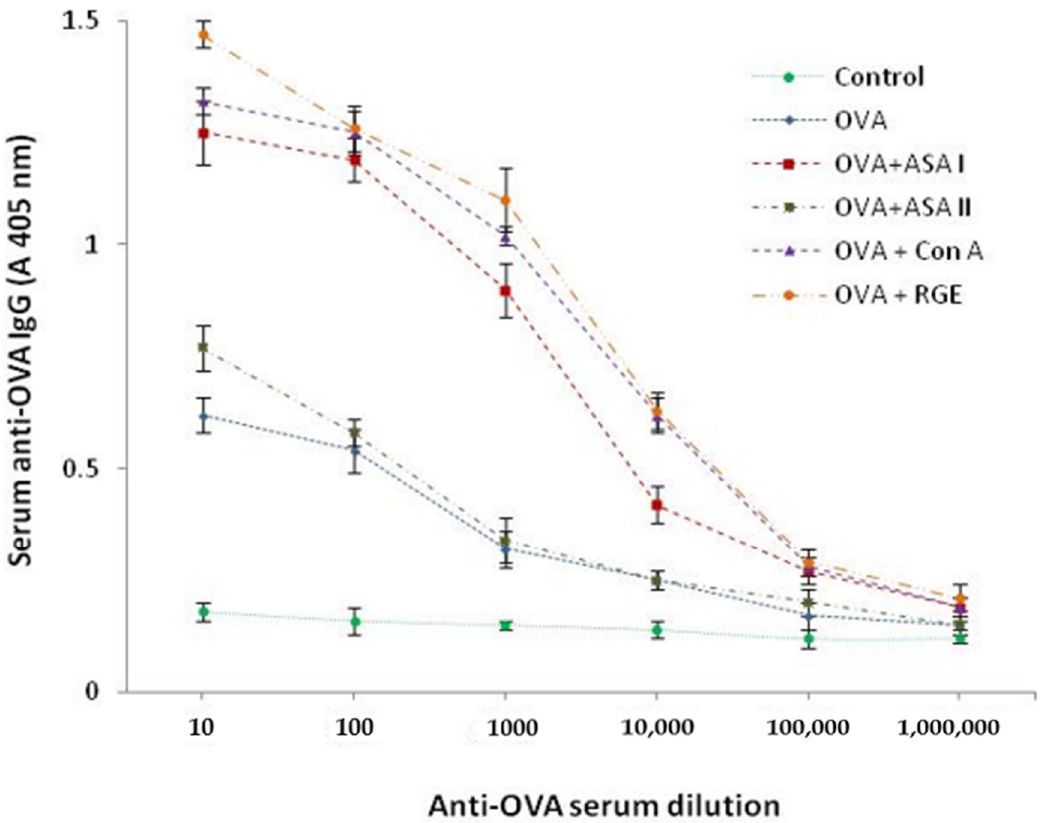
Figure 7. Anti-OVA IgG antibody titer (ELISA absorbance value at 405 nm) detected for sera obtained from untreated control and adjuvant treated experimental groups (OVA, OVA + ASA I, OVA + ASA II, OVA + Con A, OVA + RGE). Control and test proteins (100 µ L/well; 0.1 mg/mL concentration) were coated overnight, washed, blocked with BSA, and were incubated with test serum. Detection with secondary antibody conjugate (goat anti-mouse IgG-AP) and PNPP substrate. The initial dilution of serum with 1:10 and was further serially diluted by 10-fold (10 − 1 to 10 − 5 ) using the dilution